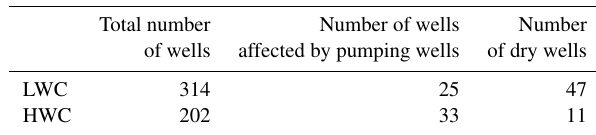
Table 2. Overview of the samples used for the application of water table